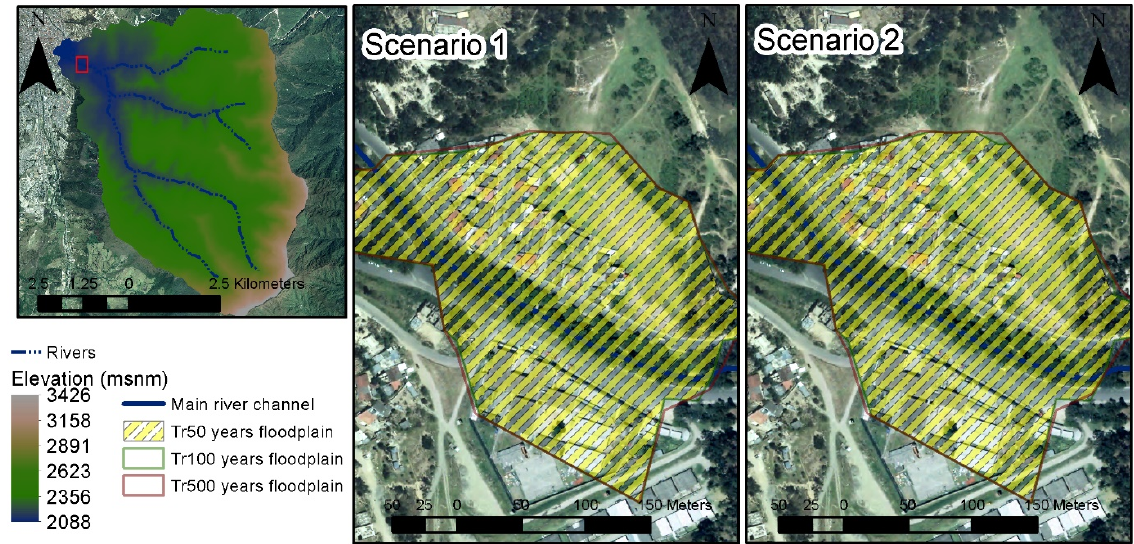
Figure 9. Floodplains for each return period and LULC scenarios in an area near to basin exit.